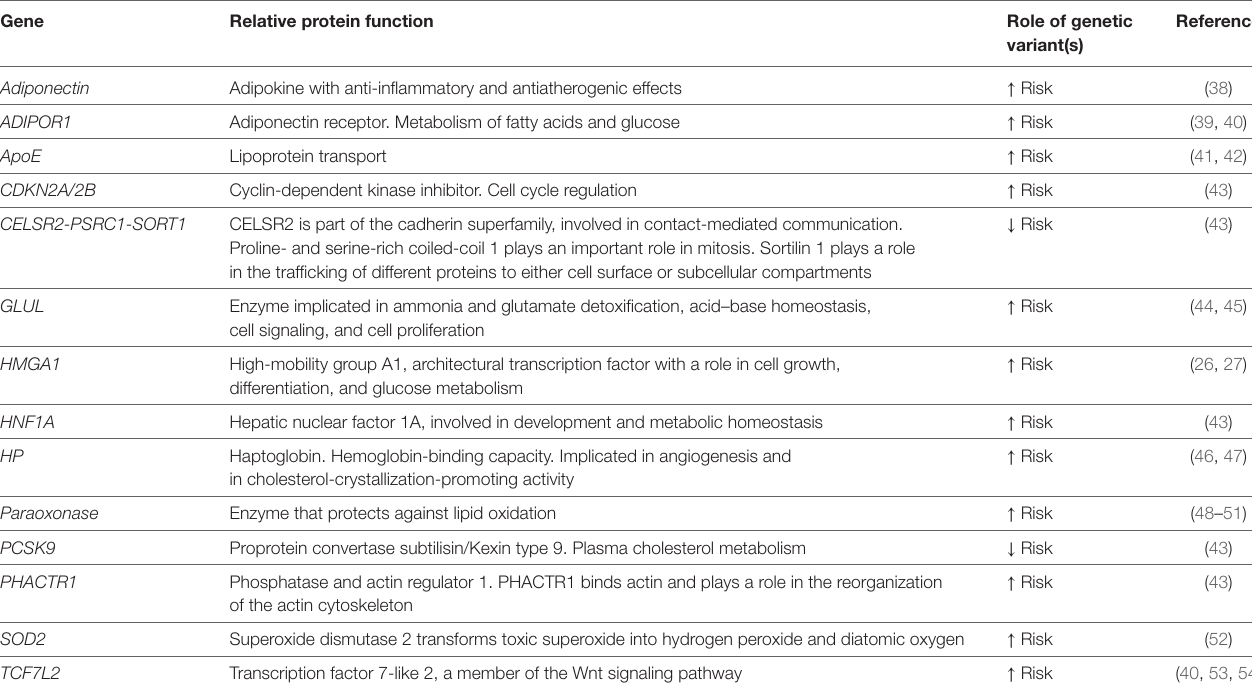
TAbLe 2 | Genes whose variants are commonly associated with both type 2 diabetes mellitus and cardiovascular disease. Gene Relative protein function Role of genetic